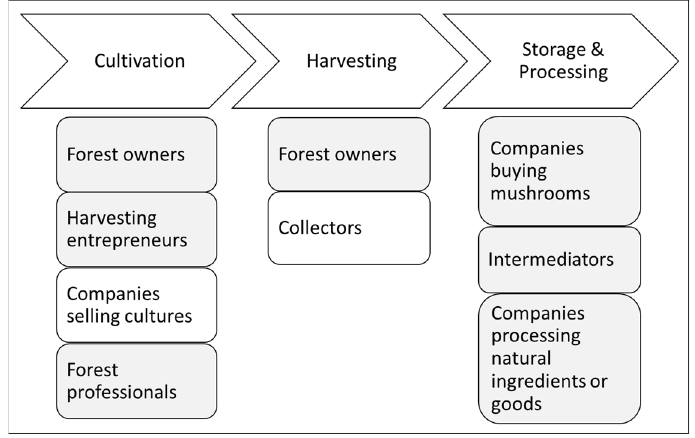
Figure 1. Supply chain actors in specialty wood-decay mushroom cultivation on stumps in connection with timber harvesting. Actors whose perspectives were studied are shaded. Table 1. Respondents’ background variables. Forest owners’ characteristics are compared to the national Forest Owner 2020 survey [16] (% of forest owners in parentheses).